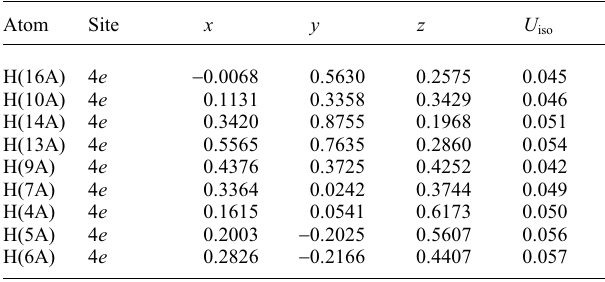
Table 2. Atomic coordinates and displacement parameters (in Å 2 )